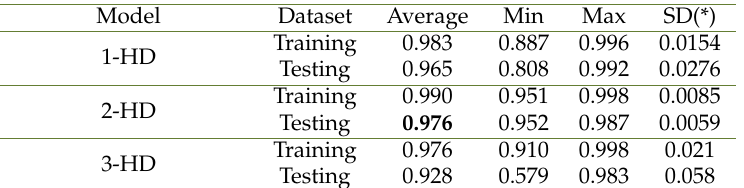
Table 5. Summary of the 1000 simulations using R 2 criteria Model